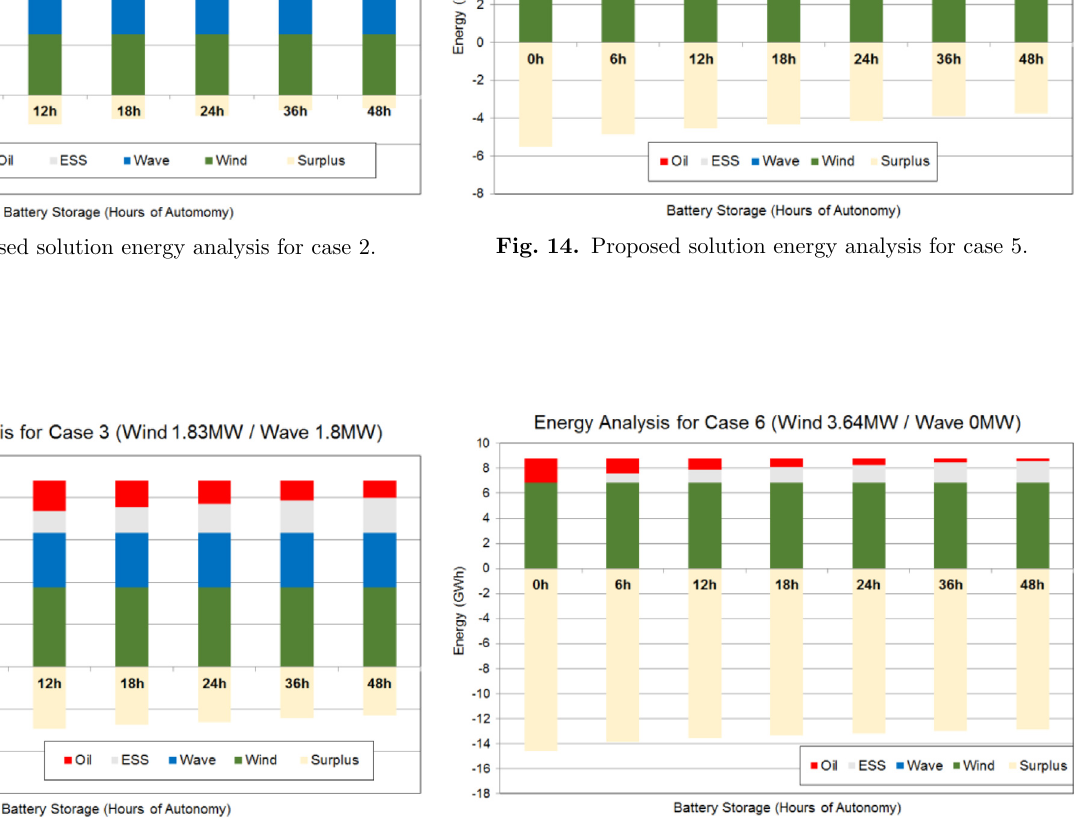
Fig. 12. Proposed solution energy analysis for case 3.